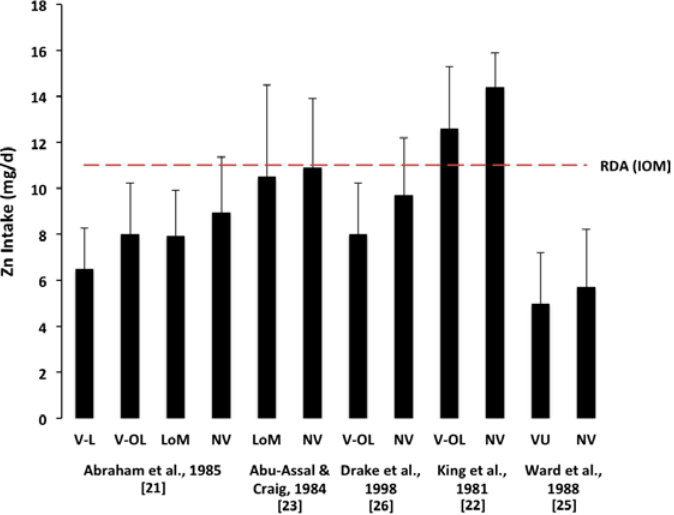
Figure 3. Relationship of dietary zinc intake to Recommended Daily Allowance (RDA). Of the five studies included in the meta-analysis of dietary zinc intake, the participants of one study [22] met the RDA of 11 mg/day established by the Institute of Medicine (IOM) [28]. Results are expressed as mean ± SD. Abbreviations: V-L, lacto-vegetarian; V-OL, ovo-lacto-vegetarian; LoM, low meat; VU, vegetarian undefined; NV,